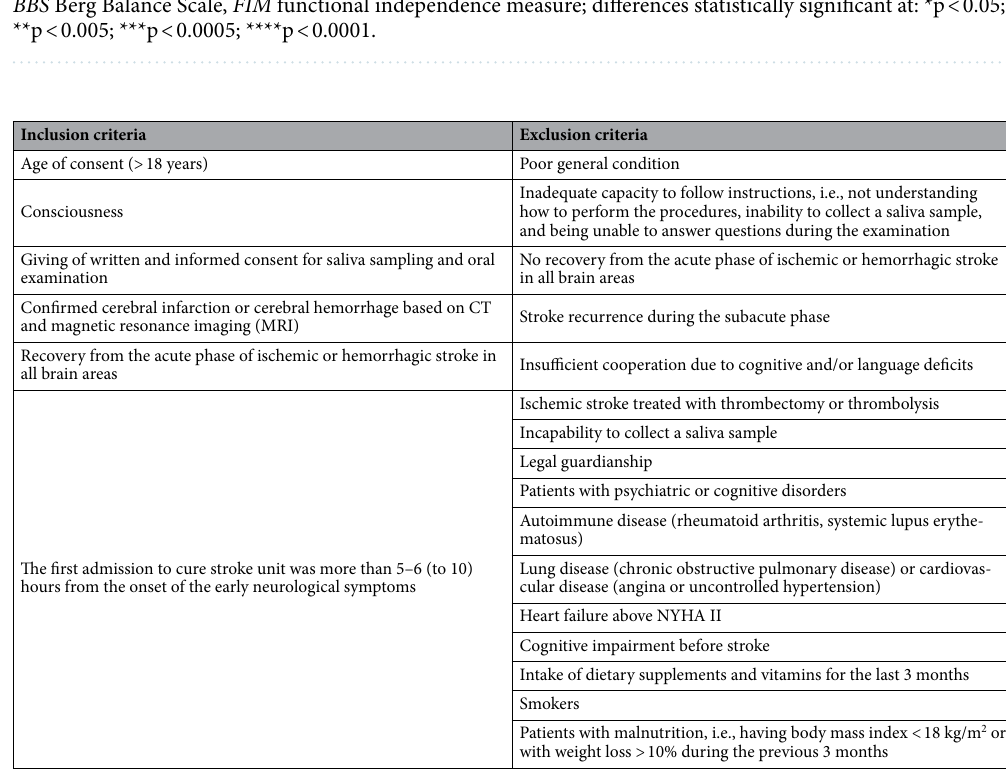
Table 2. Inclusion and exclusion criteria for the subjects in the study group. Clinical examination was performed and study material was collected in the subacute phase of stroke, between 30 and 35 days after the